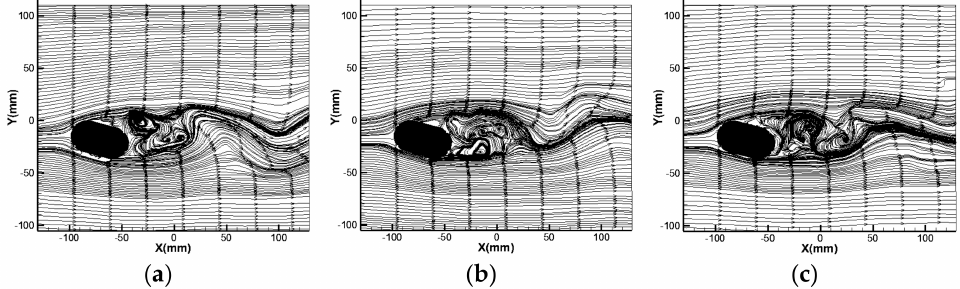
Figure 8. Instantaneous surface flow diagram of flow around a single circular ended pier with α = 15 ◦ .